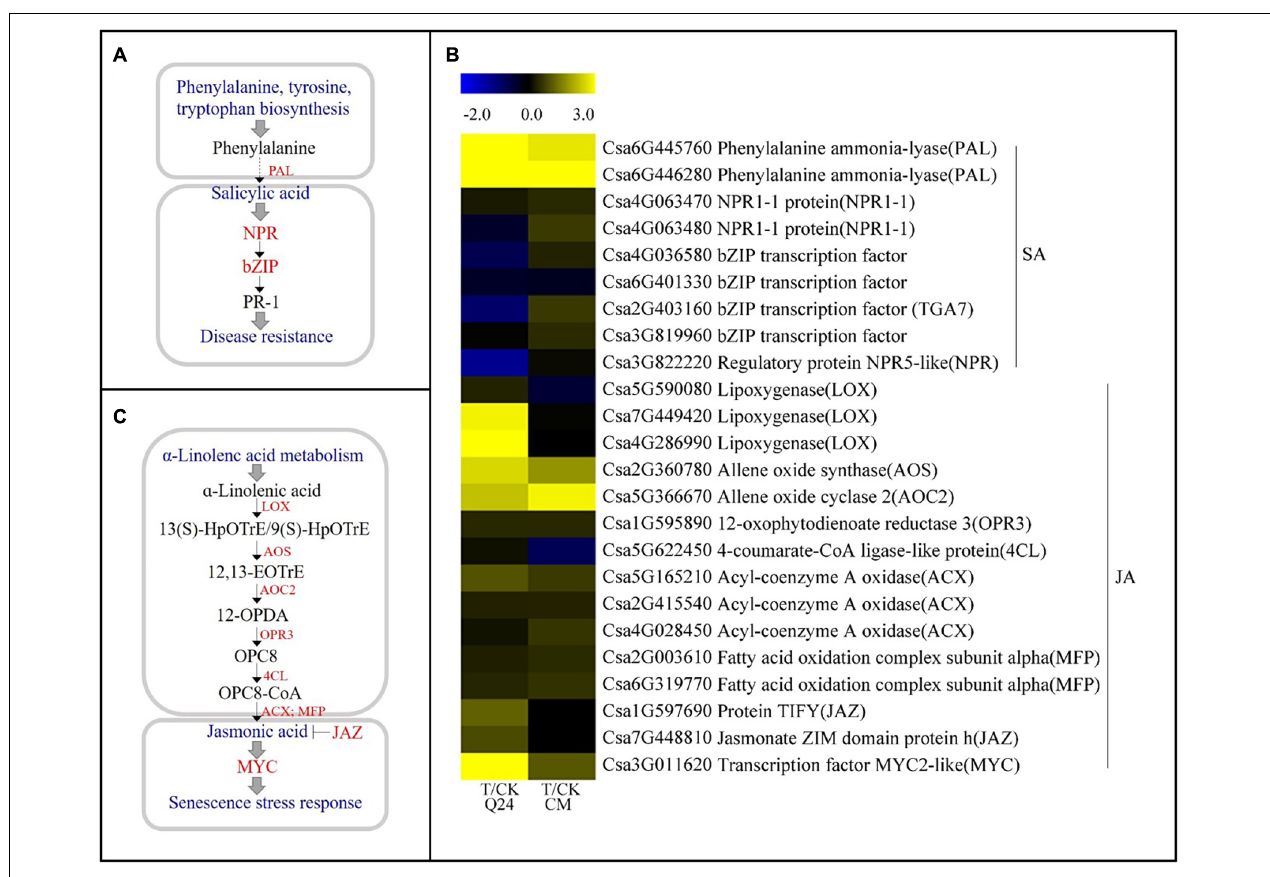
FIGURE 5 | SA and JA biosynthesis and signal transduction pathways and heat map of differentially expressed genes in Q24 and CM responding to infection. (A) SA biosynthesis and signal transduction; (B) JA biosynthesis and signal transduction; (C) the heat map showed the value of the log2FoldChange of genes compared with that of the control in SA and JA pathway in Q24 and CM. Yellow indicated up expression and blue indicated down